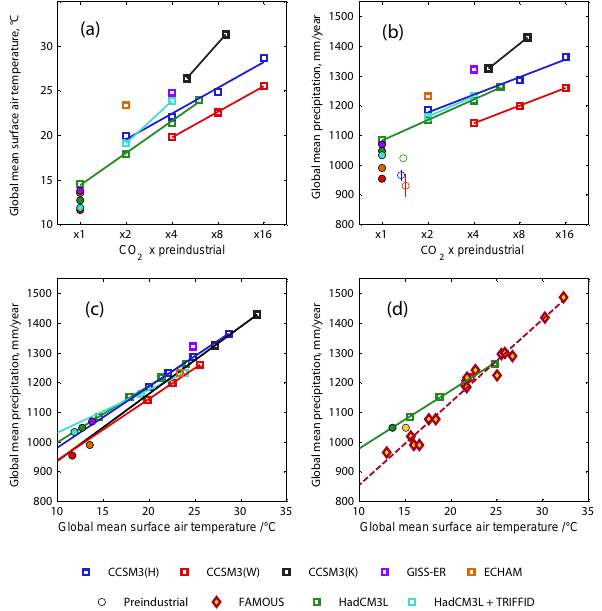
Figure 2. Global sensitivity of the Eocene hydrological cycle in the EoMIP simulations. Global mean surface air temperature relative to model CO 2 (a) , global mean precipitation rate relative to model CO 2 (b) , and global mean surface air temperature (c) ; note the log- arithmic scale on the horizontal axis in (a, b) . Preindustrial sim- ulations and Eocene simulations are shown as circles and squares respectively. The CCSM3 simulations share a preindustrial simula- tion, shown in red. Open circle symbols in (b) show modern-day estimates of global precipitation rate calculated based on CMAP data (red), GPCP data (Global Precipitation Climatology Project; Adler et al. 2003; blue), and Legates and Willmott (1990) climatol- ogy (green). Also shown is the sensitivity of the hydrological cycle to global mean surface air temperature in the 17 successful simu- lations of Sagoo et al. (2013) using FAMOUS ( d ; diamonds), with HadCM3L simulations (blue; Lunt et al., 2010) shown for compar- ison. All best-fit lines are based on Eocene simulations